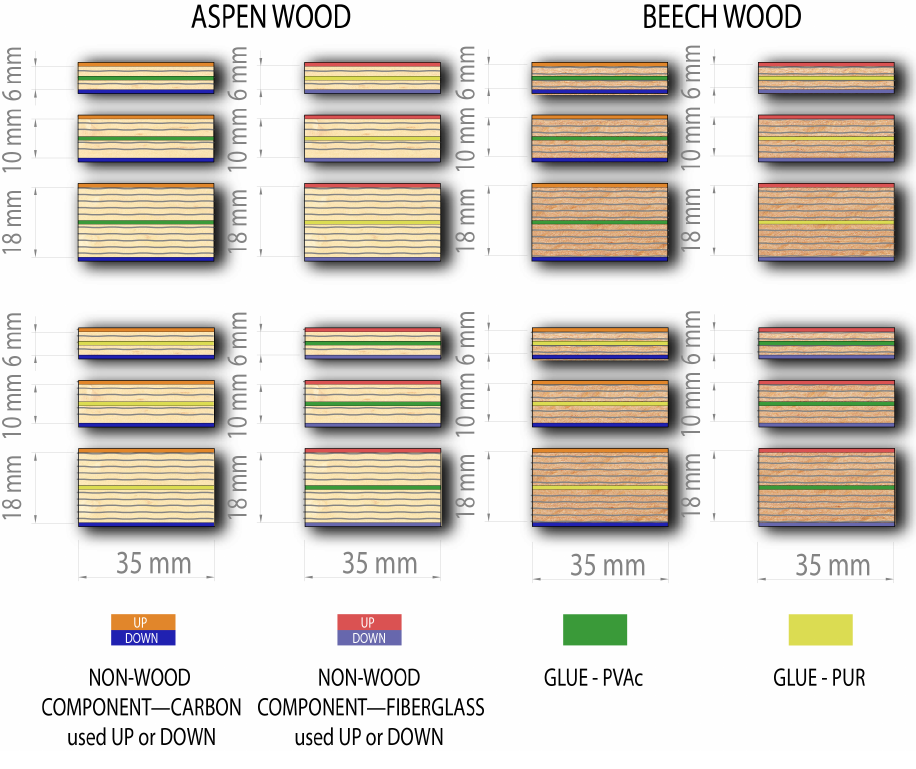
Figure 2. Categorization of test specimens.